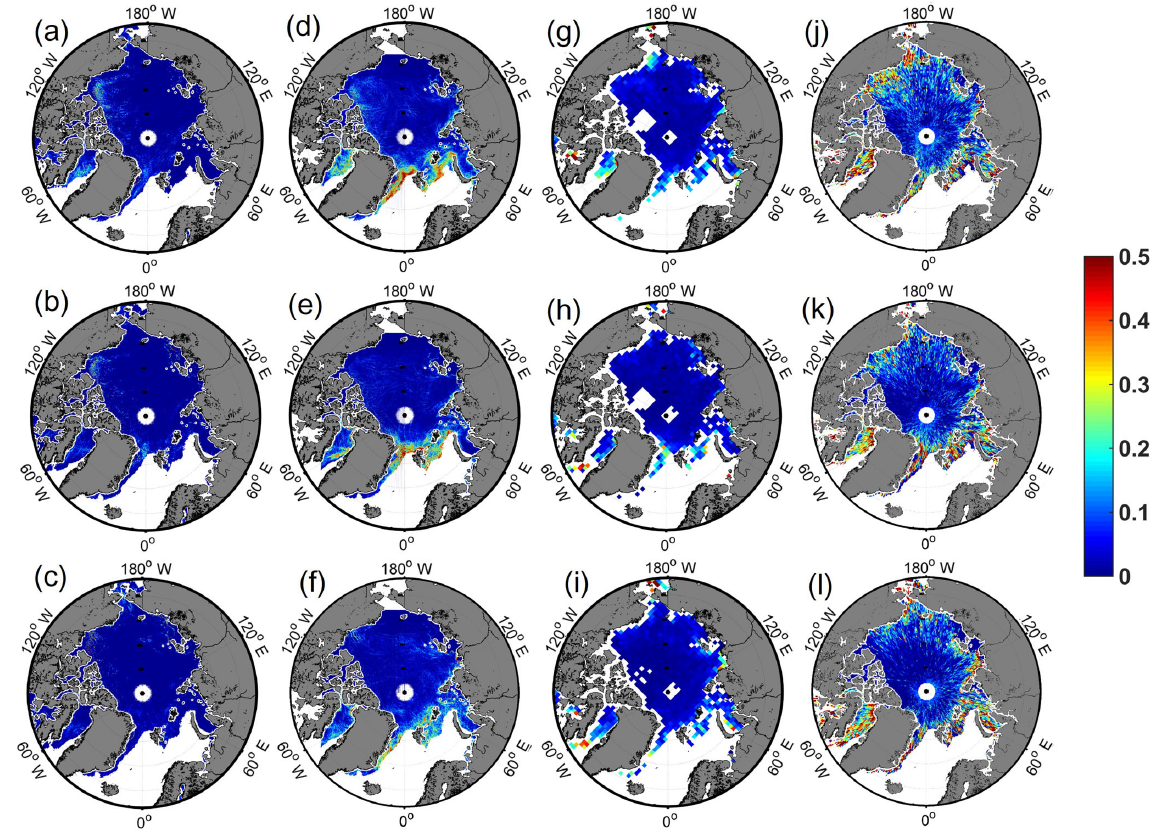
Figure 10. Comparison to other lead fraction maps from January to March 2011. (a–c) Monthly mean thin ice concentration maps using AMSR-E from Röhrs and Kaleschke (2012). (d–f) Monthly mean lead fraction maps using MODIS from Willmes and Heinemann (2015). (g-i) Monthly lead fraction maps using CryoSat-2 from Wernecke and Kaleschke (2015). (j–l) Monthly lead fraction maps based on the waveform mixture algorithm using Cryosat-2 in this